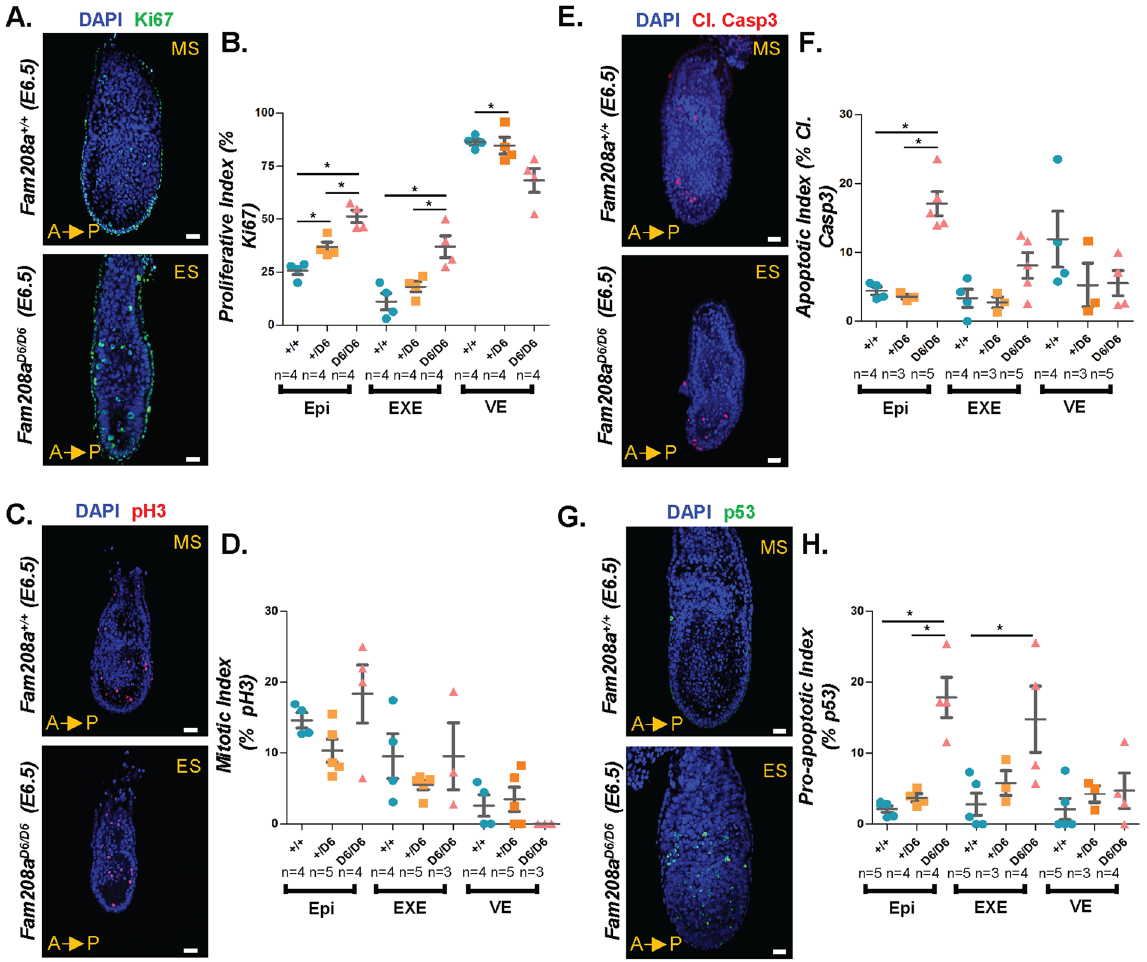
Figure 5. Fam208a D6/D6 mutants exhibit altered proliferation and increased p53-mediated apoptosis. ( A,B ) Confocal images of mutant embryos with significantly increased Ki67-positive cells (green) in Epi and ExE; * p < 0.05. ( C,D ) The mutant embryos show no significant change in pH3 (red) expression, a measure of mitotic index. (E-F) Fam208a D6/D6 mutant embryos have significantly increased apoptosis as shown by Cleaved Caspase3 positive cells (Cl. Casp3; Red) particularly in the epiblast, * p < 0.05 ( G,H ) also with pronounced increase in p53 level primarily in the epiblast and in part of the ExE region adjacent to the epiblast, * p < 0.05. All results are calculated as mean ± SEM from at least two different litters. The number of embryos analysed for each marker are